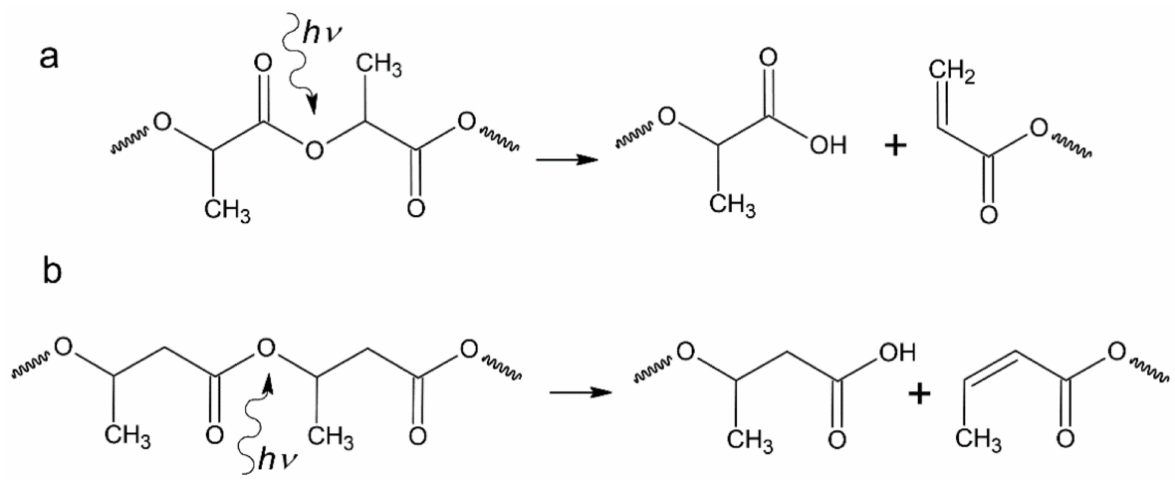
Figure 7. Scheme of PLA ( a ) and PHB ( b ) destruction under the action of UV